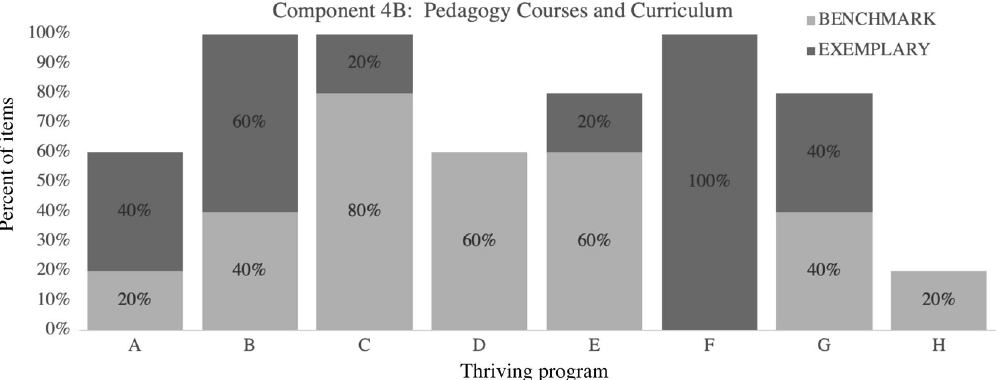
FIG. 5. Percent of items in component 4B rated at benchmark level (light gray) or exemplary level (dark gray) at each of the studied programs (A – H). Percentages are out of the number of items in component 4B, which is